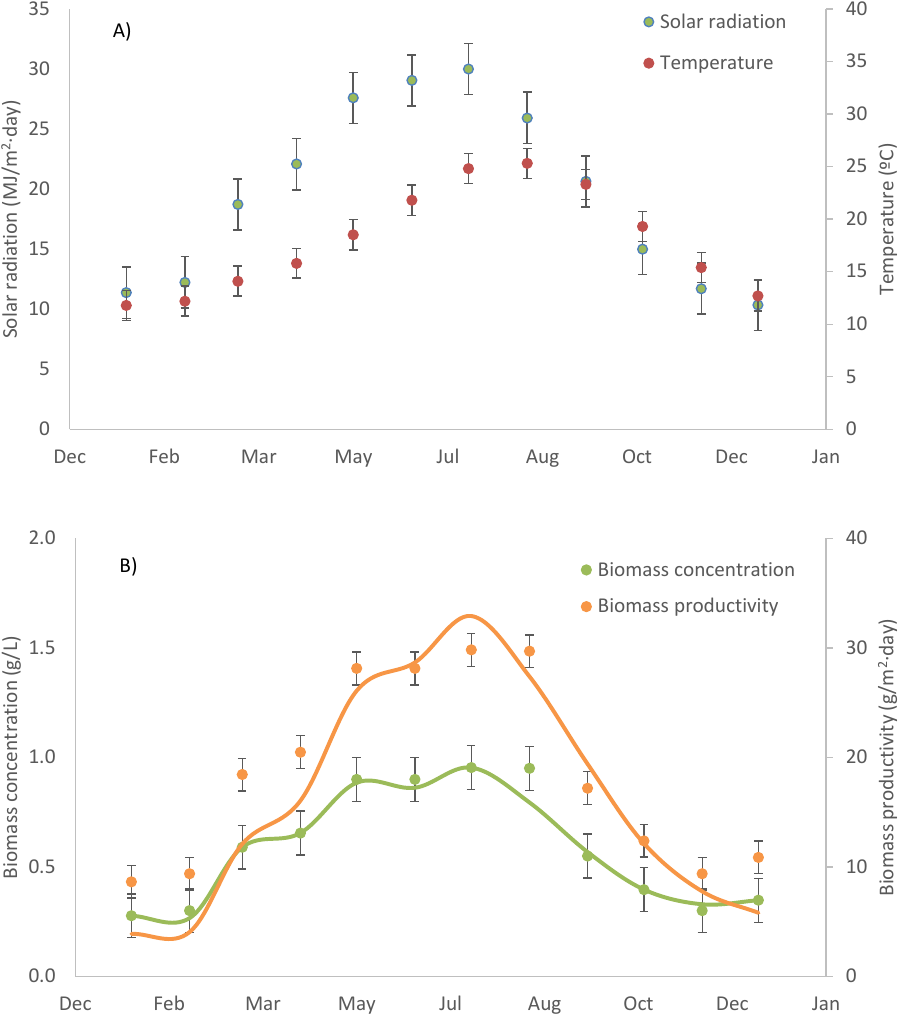
Figure 2. Annual variation in ( A ) environmental conditions (solar radiation and culture temperature) and ( B ) biomass production (concentration and productivity) of Oscillatoria sp. cultures cultivated in an 80 m 2 raceway reactor operated in semicontinuous mode at 0.2 day − 1 . Lines correspond to values estimated using the previously developed model [20].